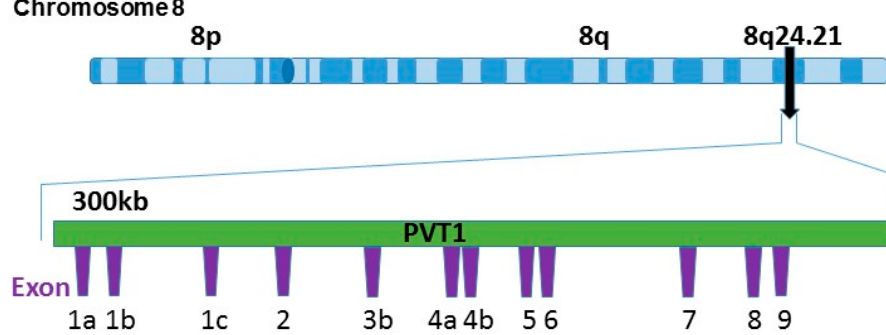
Figure 1. PVT1 localization on chromosome 8q24. PVT1 is a 300 kb long non-protein coding gene locus found at the 8q24 human chromosomal region. The PVT1 gene locus comprises at least 12 annotated